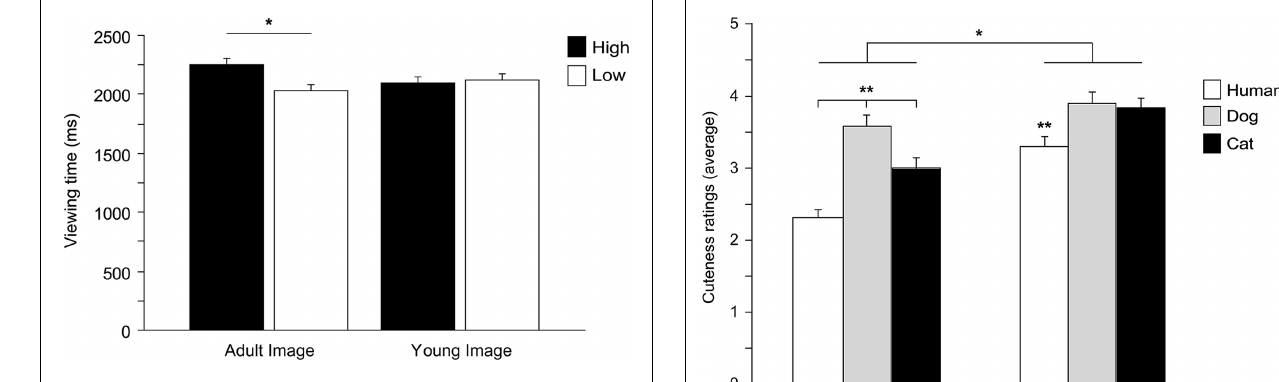
FIGURE 4 | Children’s preferential looking. Viewing time (ms) directed to high and low versions of images depicting adult and young faces. ANOVA followed byTukey post hoc test, * p < 0.05. All data are shown as mean + SEM. EXPERIMENT 2